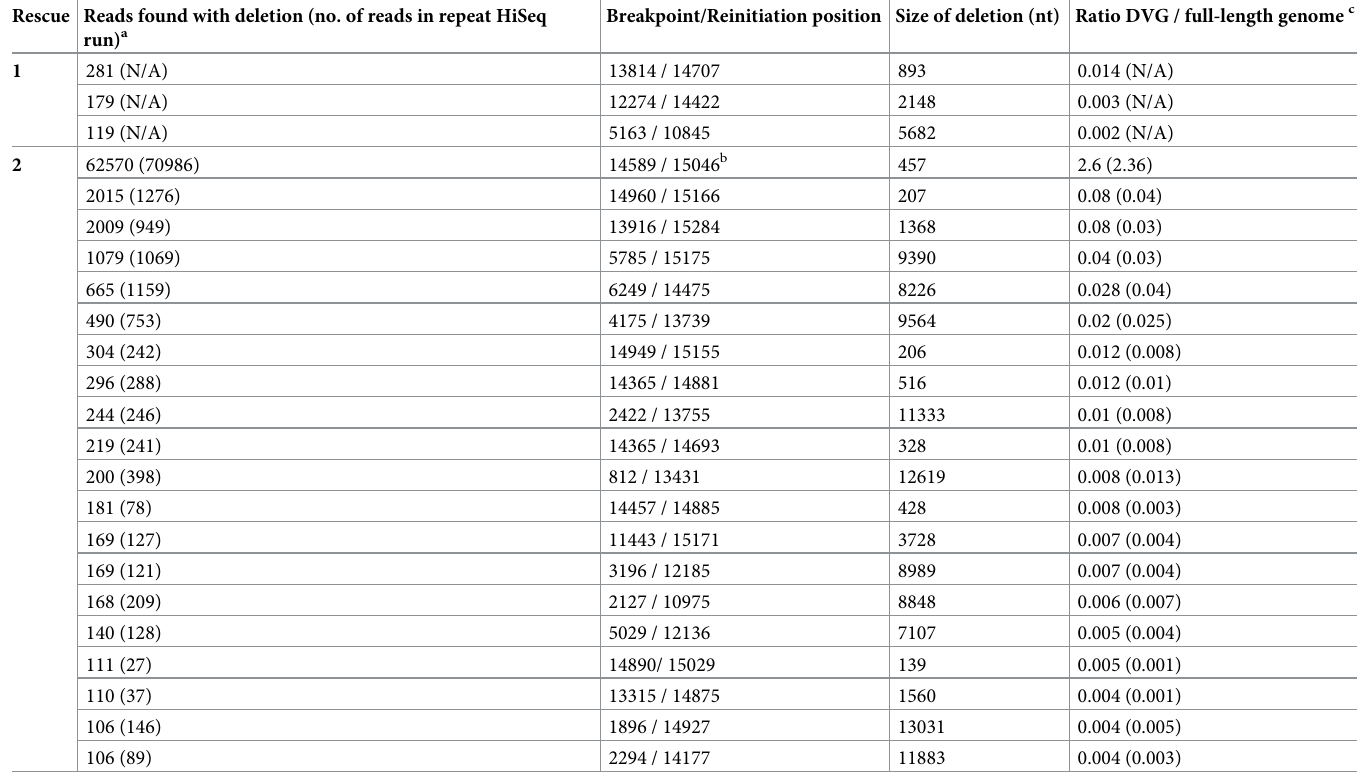
Table 5. Deletion- type DVGs identified in viruses #1 and #2 using DVG-profiler. Rescue Reads found with deletion (no. of reads in repeat HiSeq run)